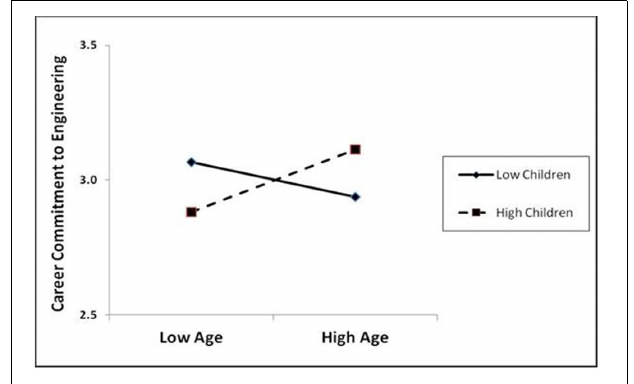
FIGURE 3 | Interaction effects of age and children on career commitment to engineering.